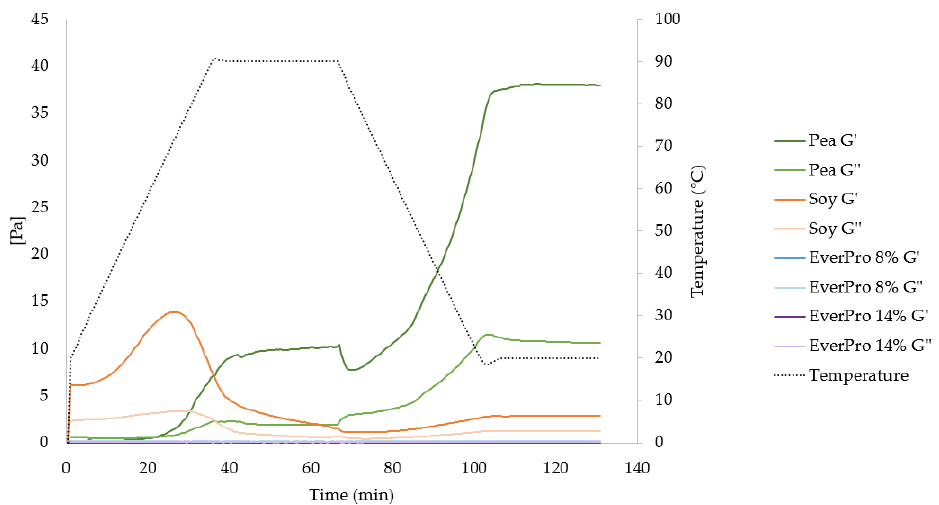
Figure 5. Rheological profiles of pea, soy and EverPro over a heating and cooling cycle, represented by the storage modulus (G’) and the loss modulus (G” ).